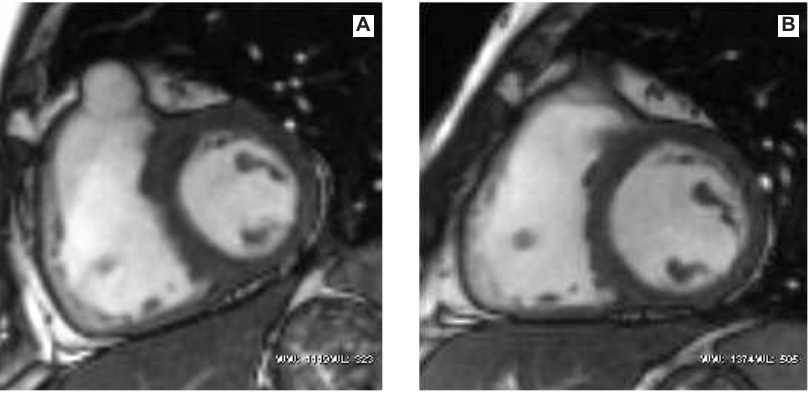
Figure 1. Cardiac nuclear magnetic resonance performed A) before and B) after a 12-month sildenafil therapy. Note the flattening of the interventricular septum with a D-shaped left ventricle in A) and the normal figure of the interventricular septum in B).